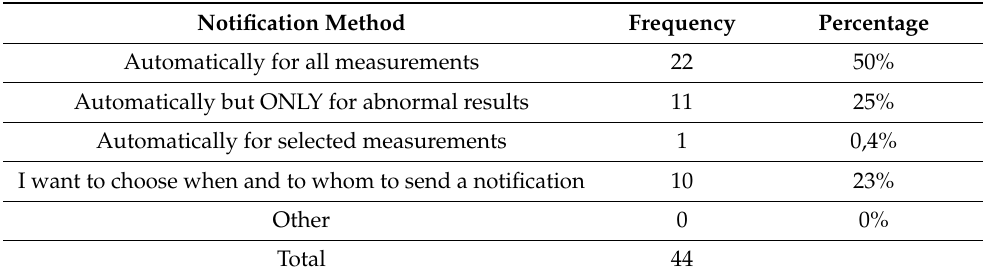
Table 8. Preferred method of notifying other people about health measurements results.